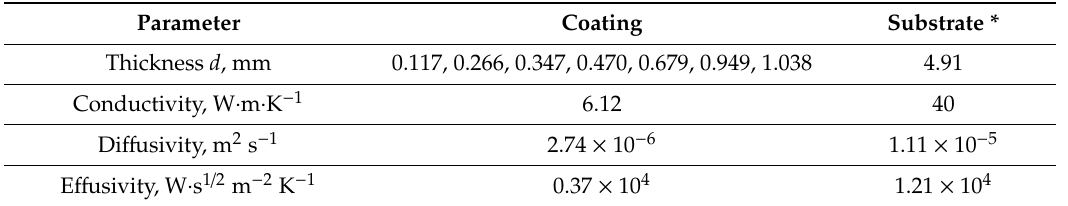
Figure 2. Coating model. Table 1. Material thermal properties used in modeling.